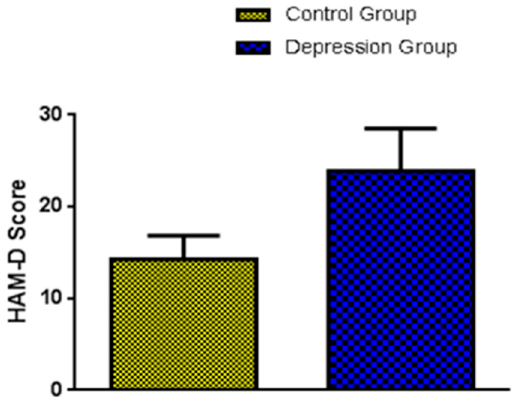
Figure 1. Participants were divided into two groups: depression group (HAM-D >19) and control group (HAM-D <19). Depression ( n = 12, 11 black and 1 white) and control ( n = 13, 12 black and 1 white) group.